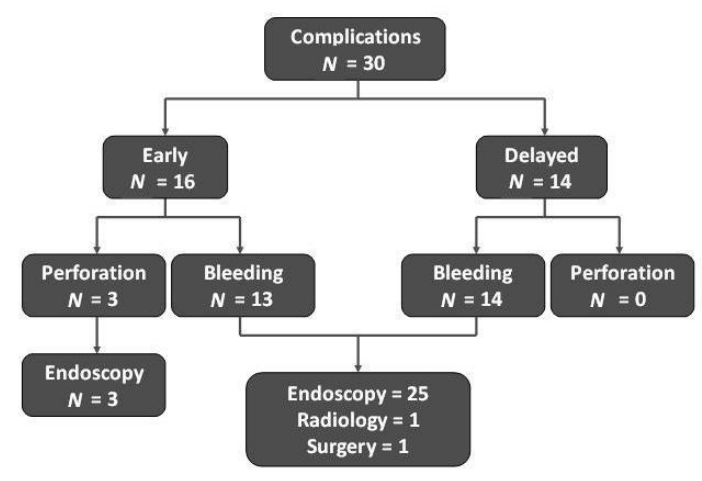
Figure 1. Post-procedural complications and their management.